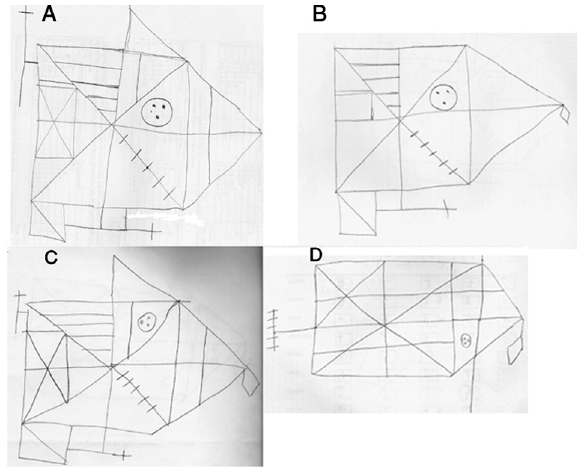
Figure 1. Example of Rey-Osterreith Complex Figure Test. A